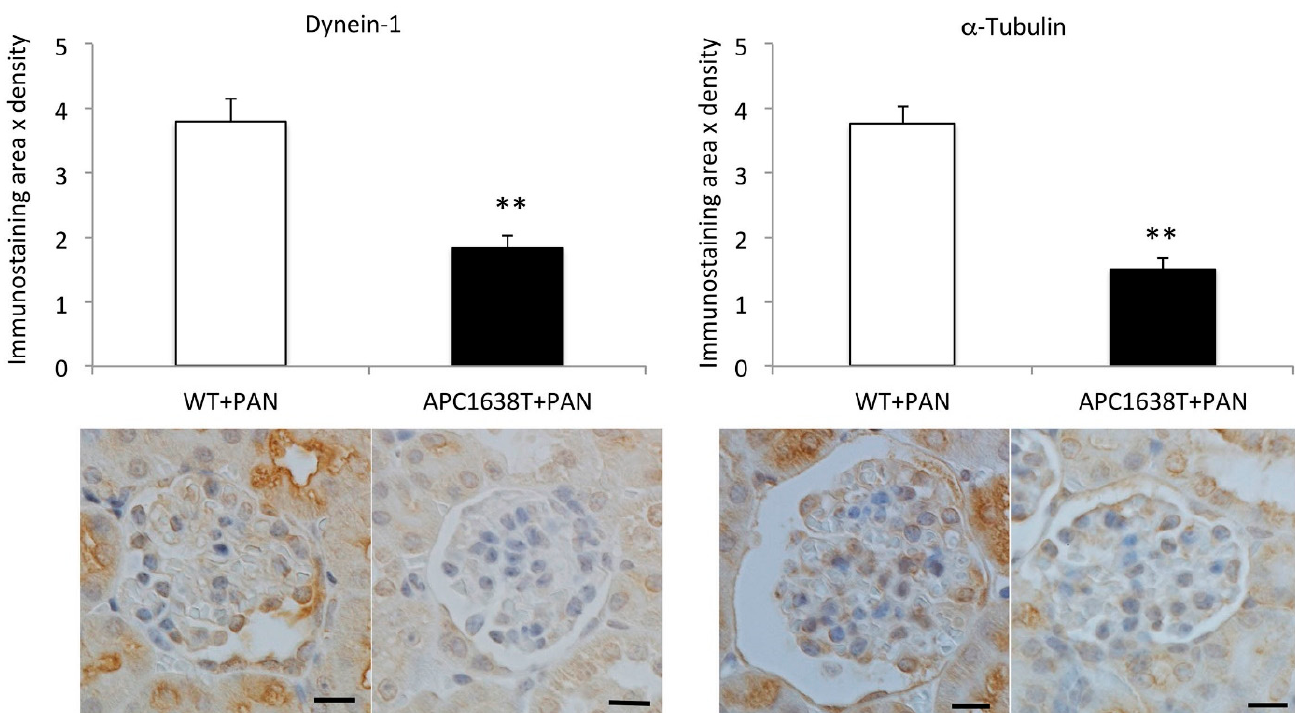
Figure 6. Immunostaining for cytoplasmic dynein-1 and α -tubulin in the kidney of PAN-induced nephrotic syndrome in the wild-type mice (WT+PAN) and APC1638T mice (APC1638T+PAN). Immunoreactivity area and density were analyzed by Image-Pro plus software and summarized as bar graphs. n = 60 glomeruli in each group of 3 mice ** p < 0.001 vs. WT+PAN. The bar indicates 10 μ m.